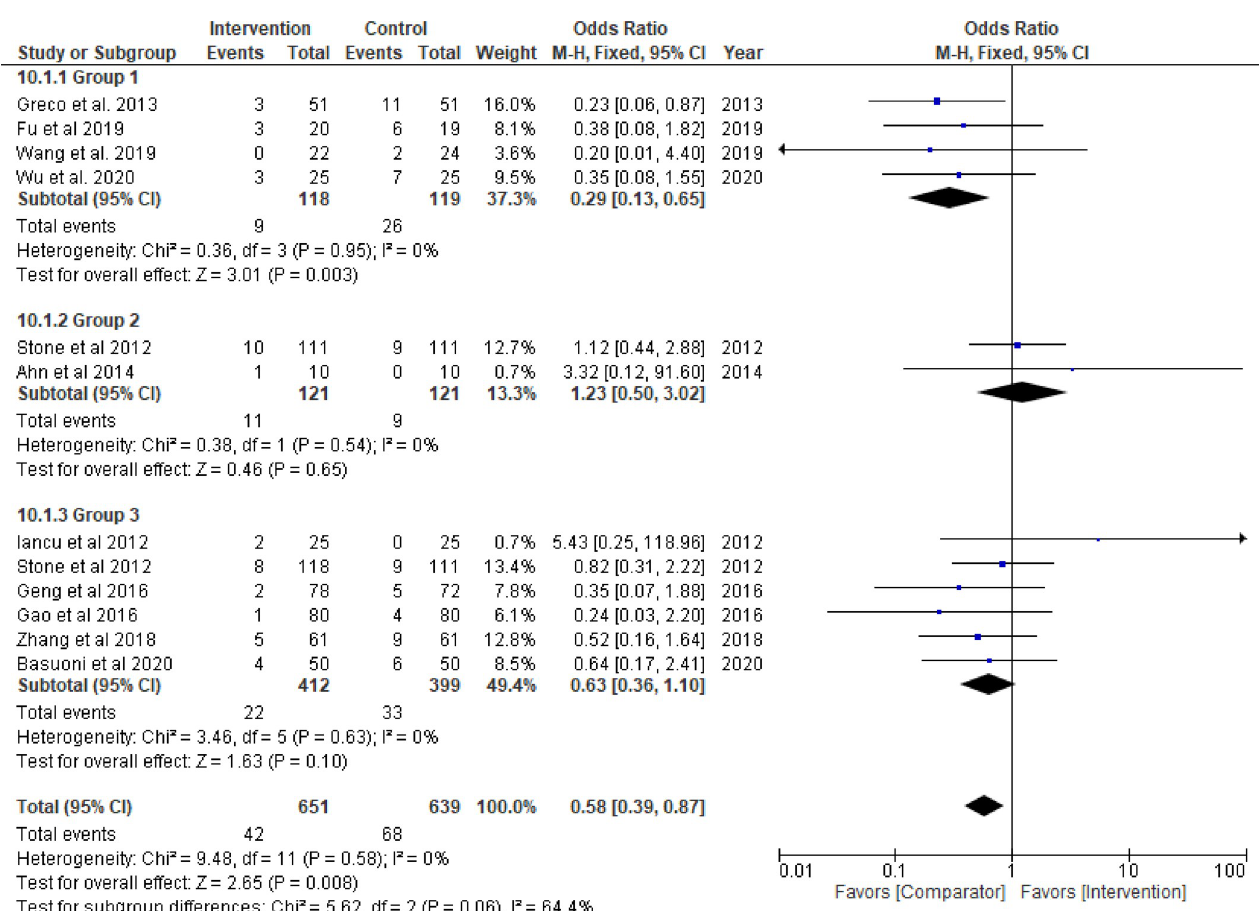
Fig 8. Major adverse cardiovascular events. Group 1: Thrombolytic agent; Group 2: Glycoprotein IIb/IIIa inhibitors (GPI); Group 3: GPI plus aspiration thrombectomy.